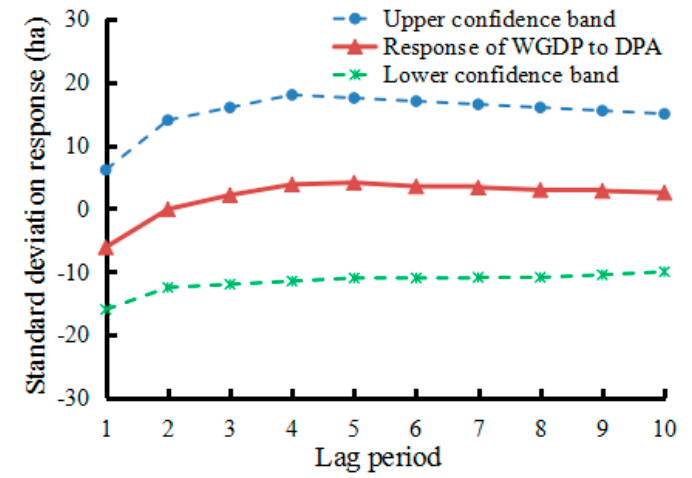
Figure 3. Standard deviation response of WGDP to DPA.